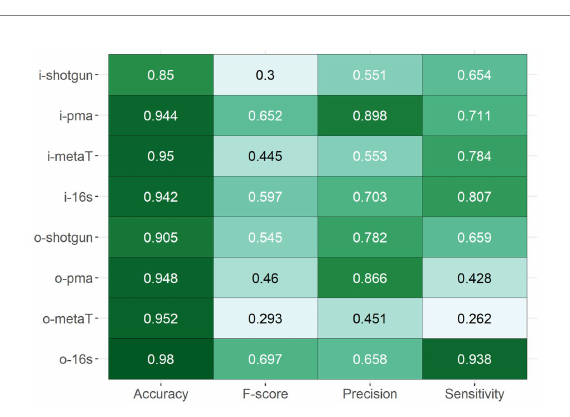
FIGURE 2 Overall performance of methods based on the accuracy, F-score, precision, and